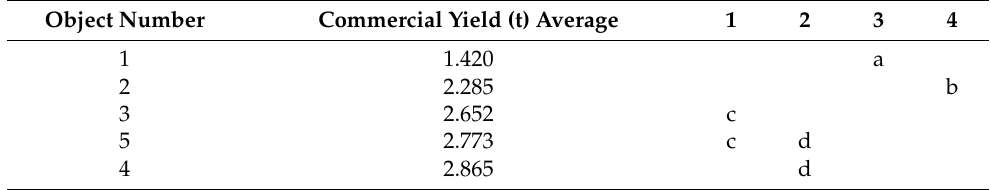
Table 8. Homogeneous groups for marketable yield, obtained via the Tukey